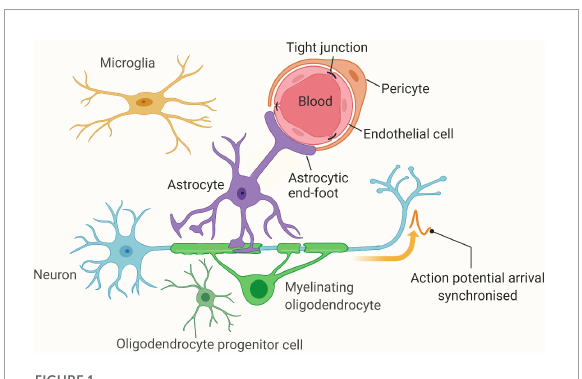
FIGURE1 The Neurovascular Unit (NVU). Vascular (endothelial cells and pericytes) and brain (astrocytes, oligodendrocytes, and neurons) cells interact and function as a unit, millions of which reside in the brain. Figure created using